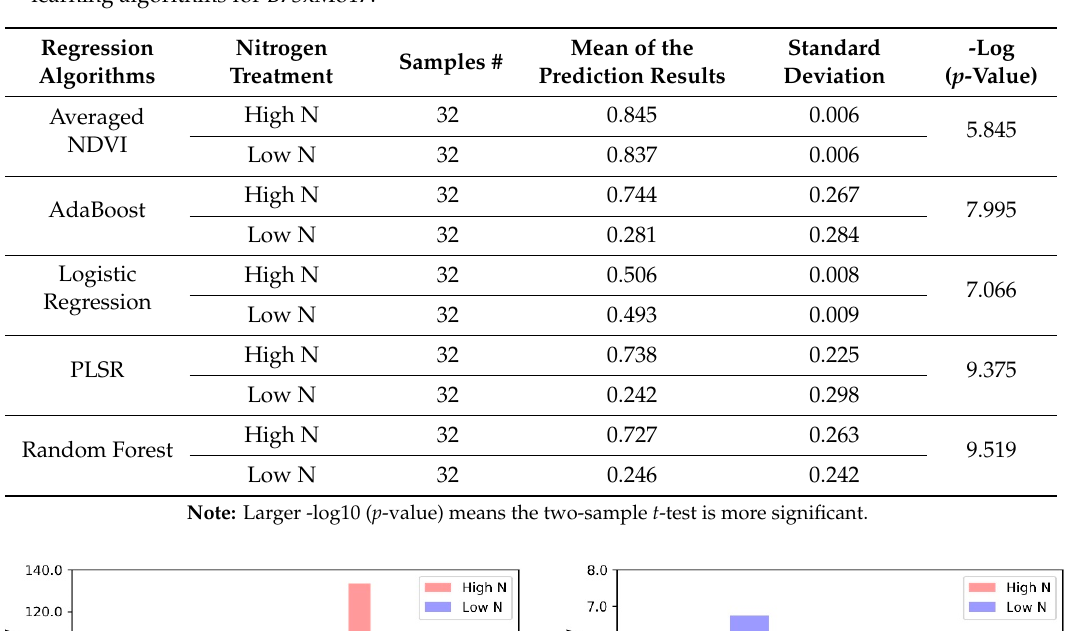
Table 3. The results of the averaged NDVI values and the prediction results from different machine learning algorithms for B73xMo17.